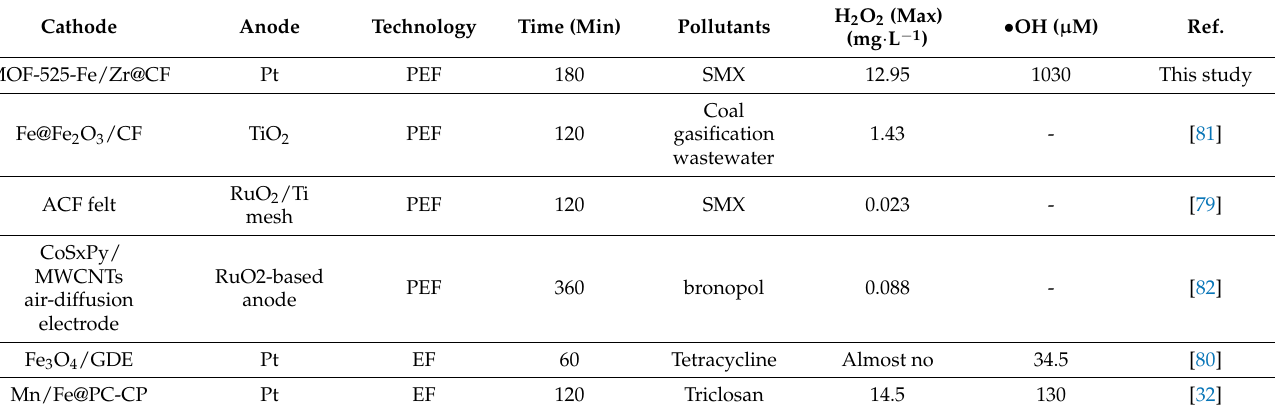
Table 4. The production of H 2 O 2 and • OH in catalytic Fenton-like systems is summarized and